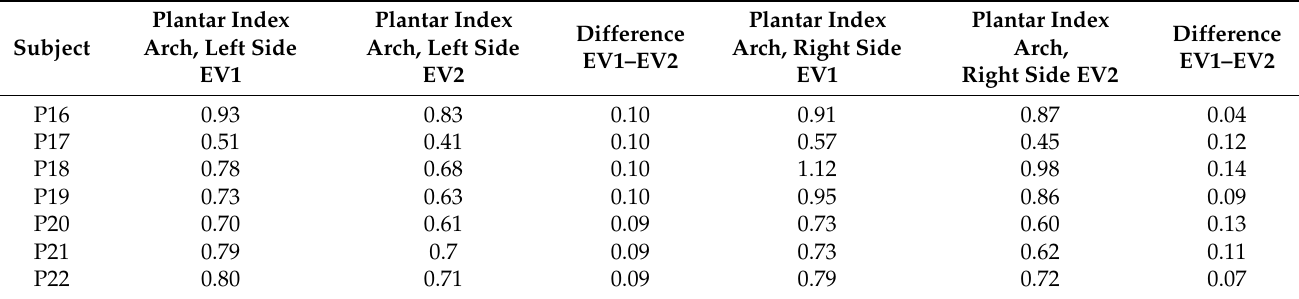
Table 2. Plantar index arch evolution (Group 1, n =